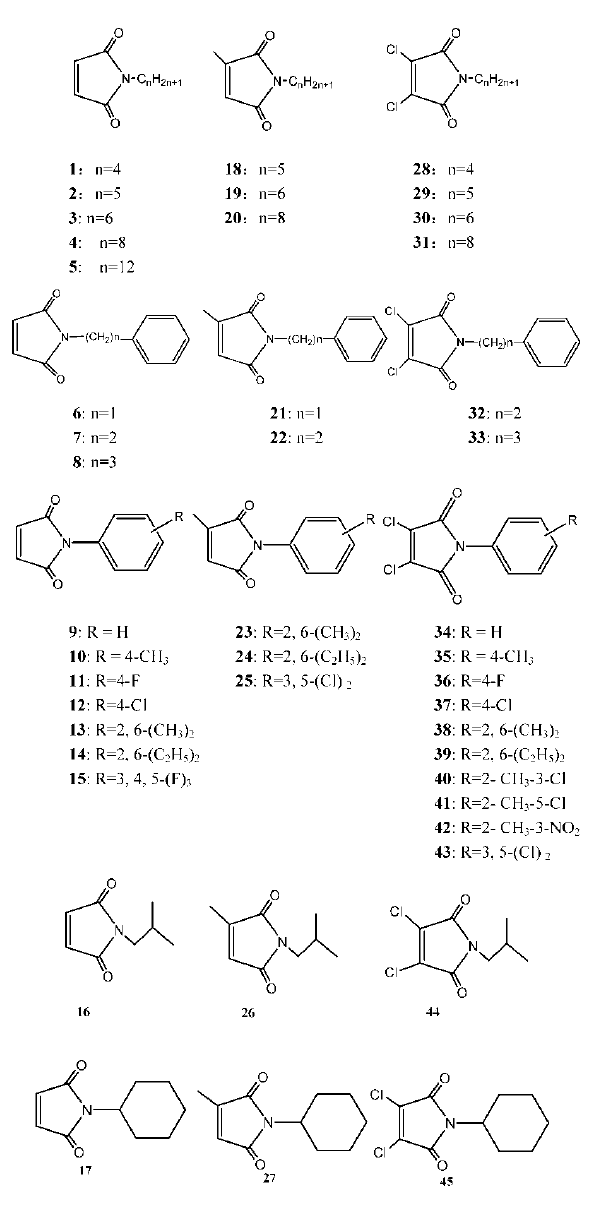
Figure 1. Chemical structures of the studied N -substituted maleimides.